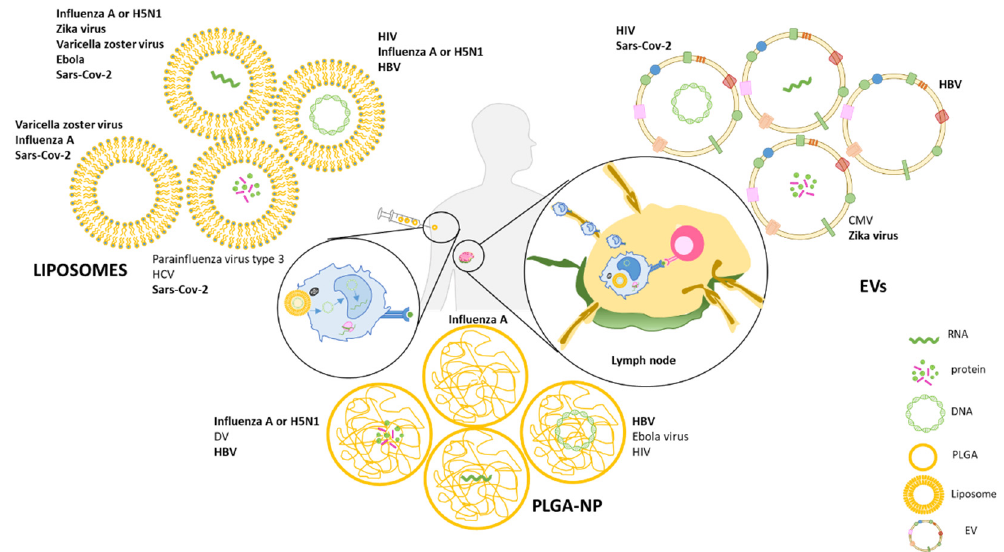
Figure 1. Overview of liposomes, EVs and PLGA-NPs as carriers for vaccines against viral infections. Proteins, plasmid DNA and mRNA have been successfully formulated in these NPs; empty NPs can also be used as adjuvant in vaccine formulation. Upon injection, they are internalized by APCs and, by reaching the lymph nodes, they present the viral antigen to T cells in order to induce an immune response. Some of these advanced vaccines were successful in eradicating the related viral infections (shown in bold). HBV: Hepatitis B Virus, HCV: Hepatitis C Virus; DV: Dengue Virus; CMV: cytomegalovirus; HIV: Human Immunodeficiency Virus: Sars-CoV-2: Severe Acute Respiratory Syndrome Coronavirus 2.